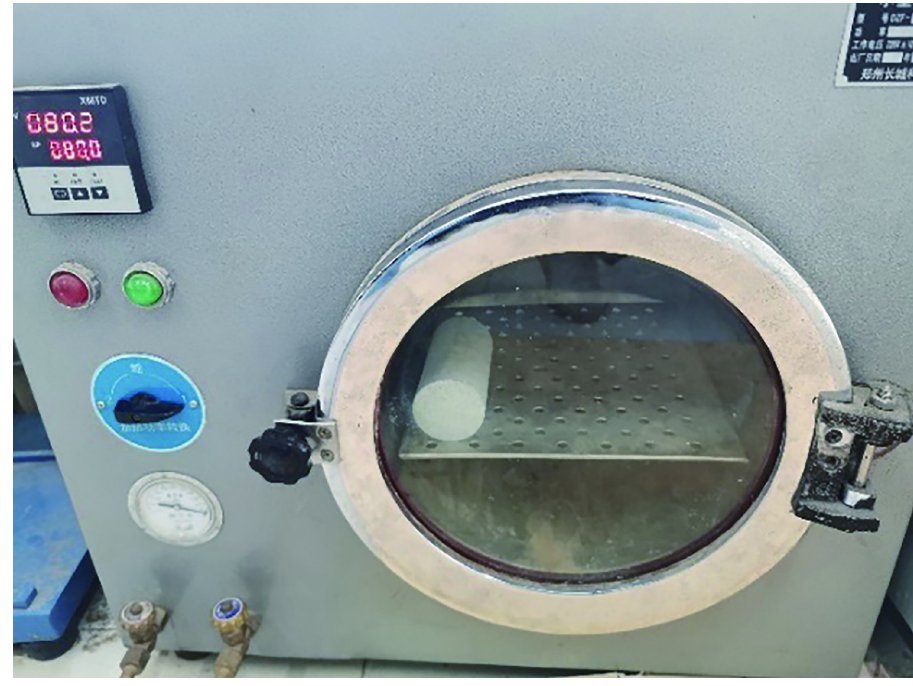
Fig 12. Specimen heating